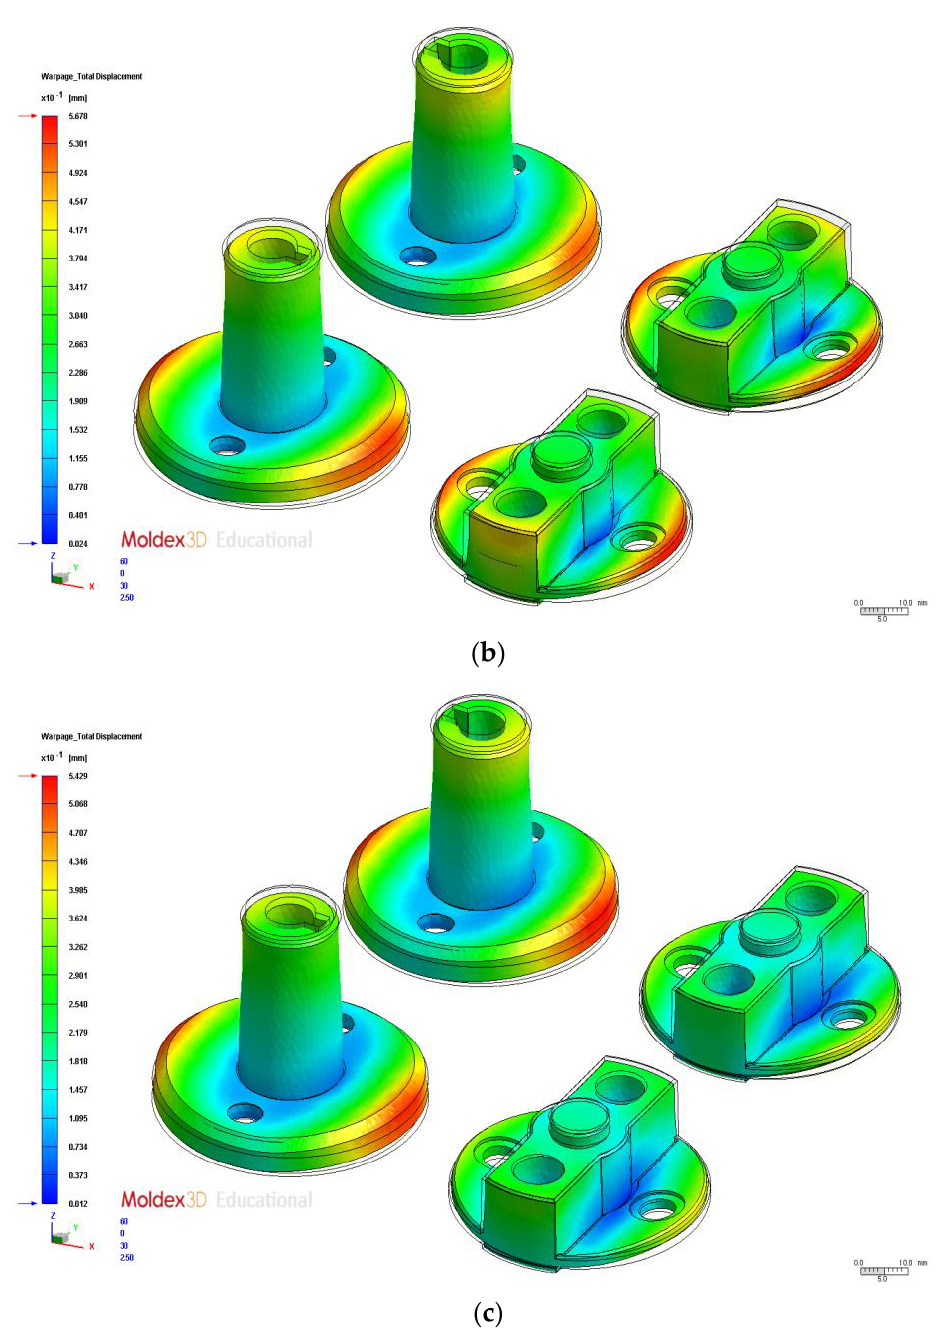
Figure 13. Comparison of Total Warpage. ( a ) Original cooling. ( b ) U-shaped cooling. ( c ) Confor- mal